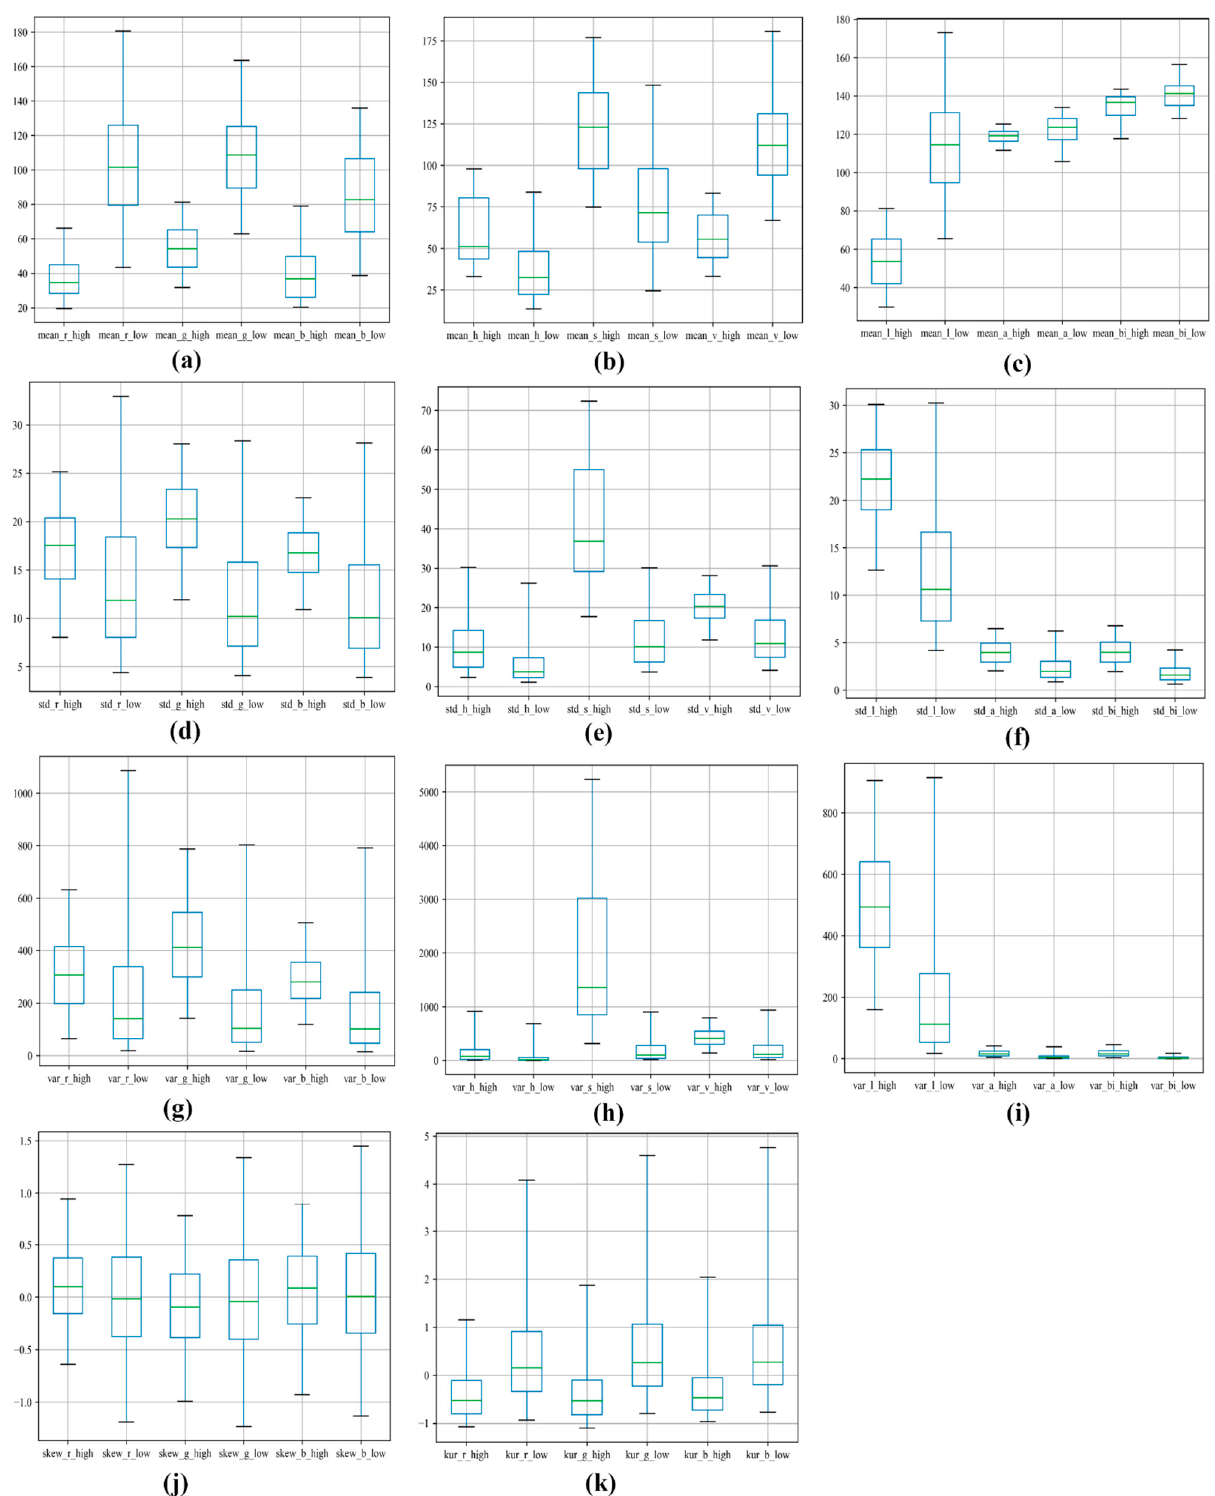
Figure 5. Comparison of high- and low-density vegetation patches for color space statistical moments where ( a – c ) are the mean values of the color spaces, ( d – f ) are the standard deviations of the color spaces, ( g – i ) are the variances of the color spaces, and ( j , k ) are the skew and kurtosis of the RGB color space.